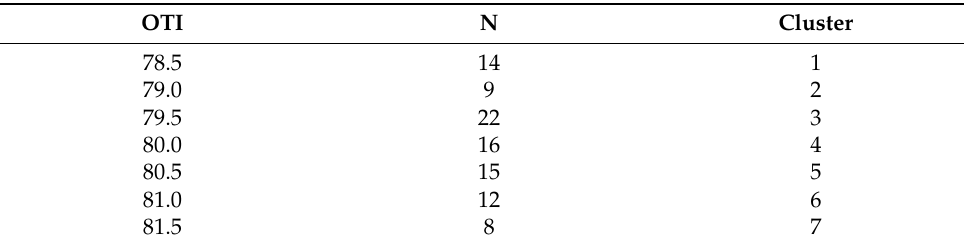
Table 2. Clustering of the OTI values as a function of the number of subjects (N).